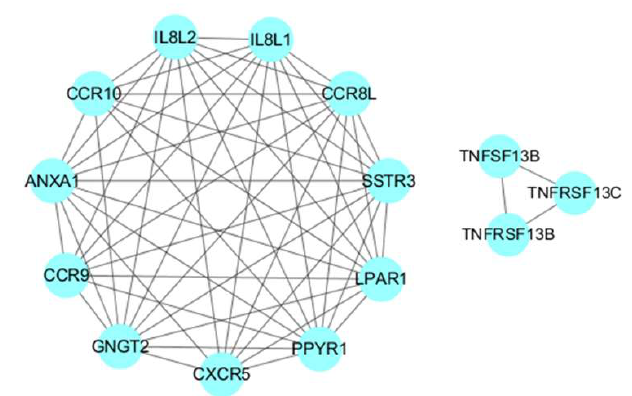
Figure 7. Important modules of the protein-protein interaction (PPI) network. The connection between proteins indicated that they interact and the confidence interval was greater than 0.7 .